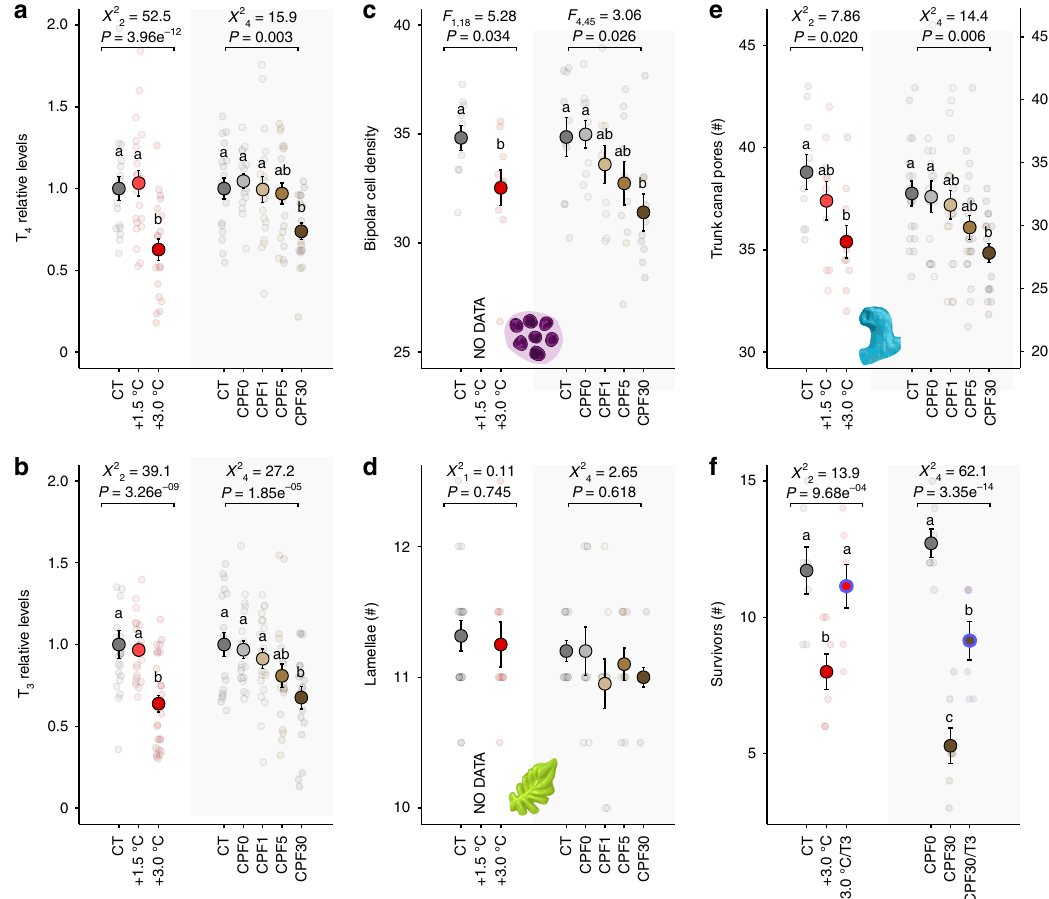
Fig. 3 Effects of increased temperature and chlorpyrifos on TH levels, sensory organ development, and survival. a – e Respective T 4 -levels ( n = 150), T 3 - levels ( n = 167), bipolar cell densities ( n = 70), number of lamellae ( n = 79), and lateral line canal pores ( n = 123) in d2 A. triostegus exposed to increased temperature (CT = control, 28.5 °C; + 1.5 °C = 30.0 °C; + 3.0 °C = 31.5 °C; white panels) and CPF (CT = control, no CPF; CPF0 = acetone solvent control; CPF1, CPF5 and CPF30 = CPF at 1, 5, and 30 µ g L − 1 , respectively; gray panels). f Differential survival, in a predation arena, of d2 A. triostegus exposed to increased temperature or CPF and across hormonal treatments ( n = 630 fi shes in n = 7 replicates). Data are indicated as mean (opaque circles)± SE (error bars), and transparent circles indicate each data point. Letters indicate statistically different groups according to two-sided Tukey post hoc tests following Gamma GLMEM ( χ 2 in a , b ), LM ( F ), or COM-Poisson GLM ( χ 2 in d – f ). Source data are provided as a Source Data fi